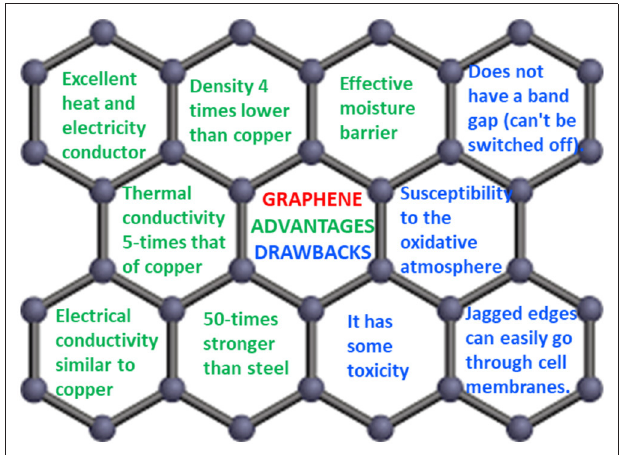
Frontiers in Chemistry |